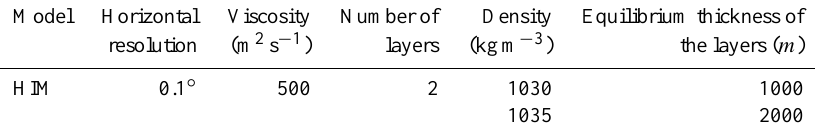
Table 1. Relevant parameters of the idealized experiments used for both open ITF (HIM CTRL) and closed ITF (HIM NoITF) cases. Model